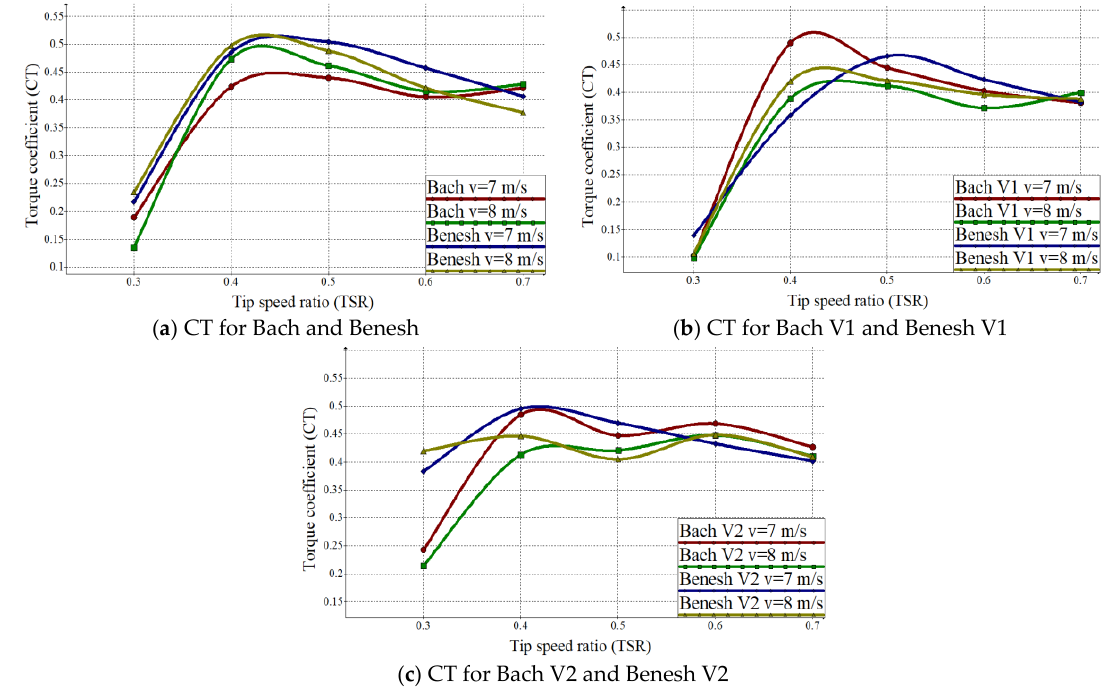
Figure 10. Torque coefficient (CT) for analyzed rotor models.